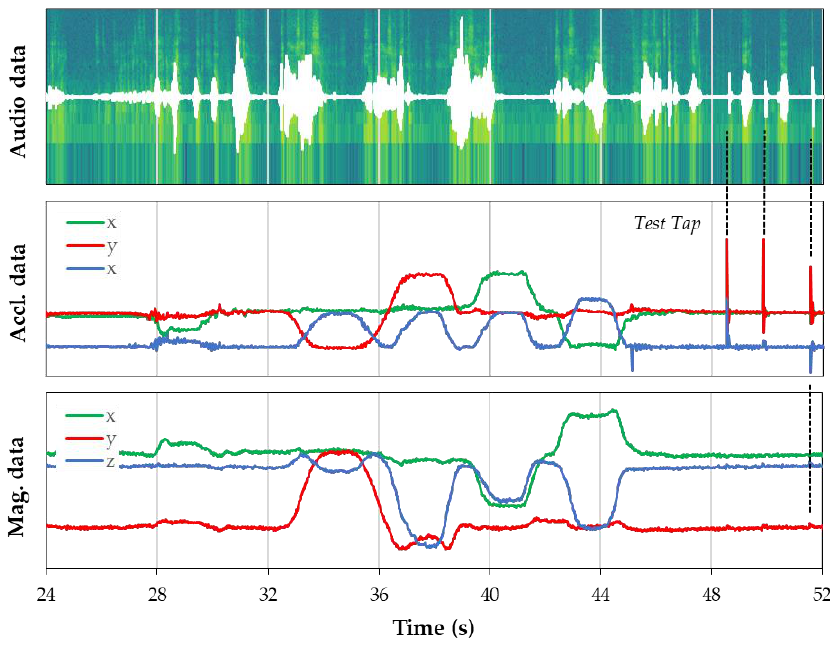
Figure 18. Example of time-aligned recorded data.